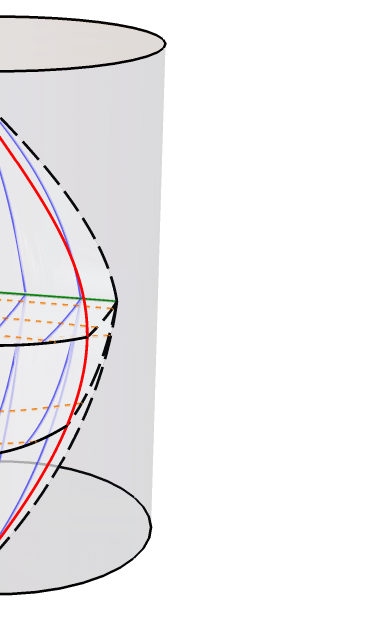
Figure 22 . The Class I rapid,C solution, as a portion of global AdS 3 . Several surfaces of constant t are shown. The horizon is shown by the surfaces at early and late times, with the bifuration surface shown in green. The lines x = x + and x 0 = x + within each time-slice (shown in long-dashed black) are identified, which imbues the birfurcation surface with the topology of a circle. Lines of constant x are shown in blue, with lines of constant y shown in dashed orange. The classically accessible subset of the global boundary is delimited in red. To guide the eye, the locus of the cylinder is shown in solid